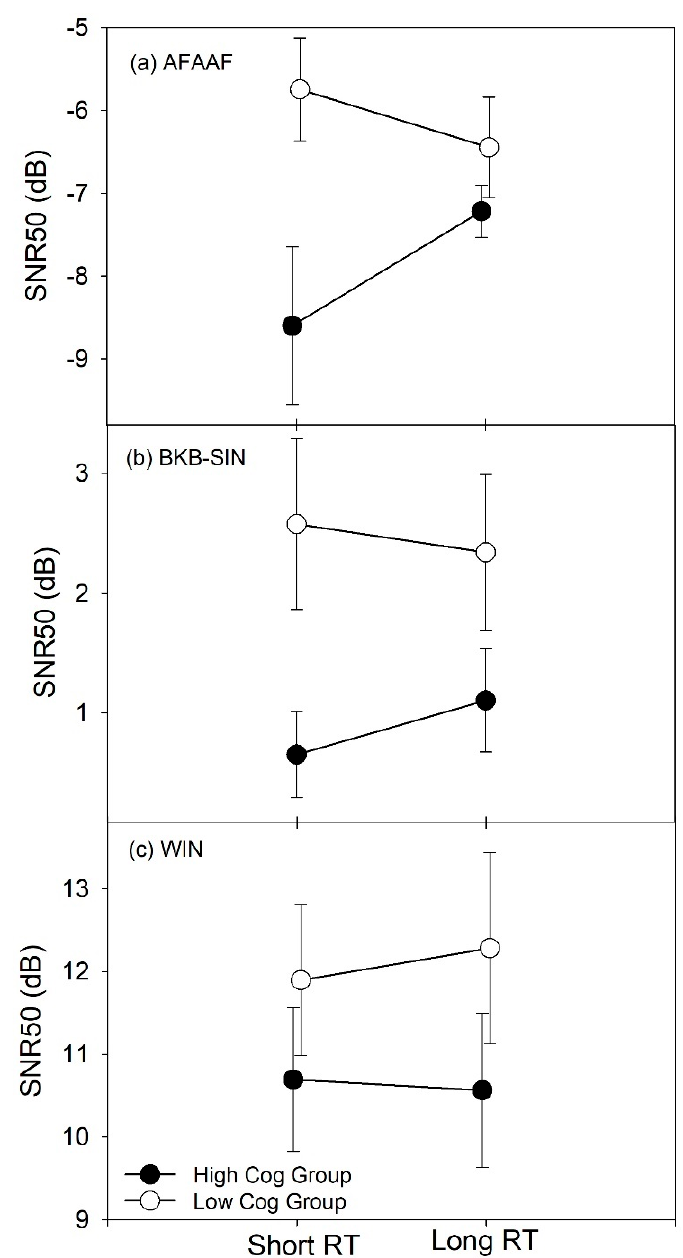
Figure 8. Relationship between cognitive performance groups and RT when using each of the three speech recognition tests. Error bars represent standard errors.